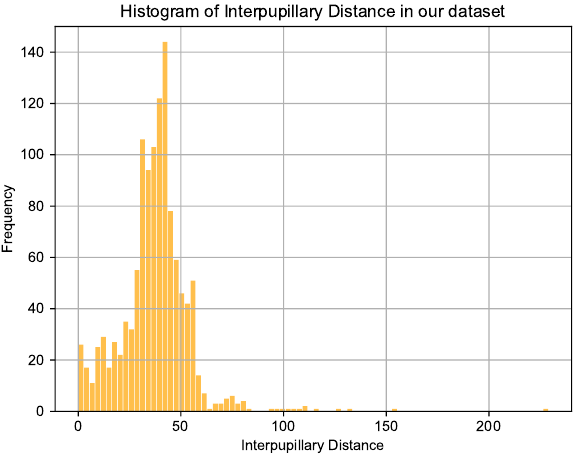
Figure 8. Histogram of interpupillary distances across various players in our